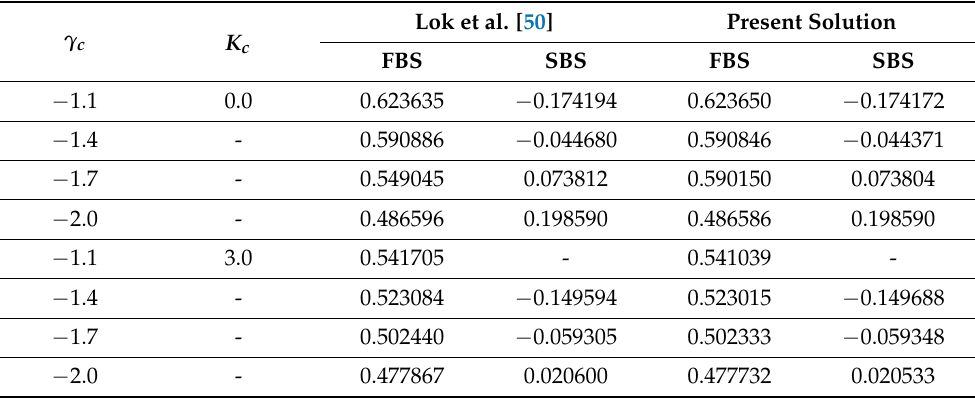
Table 3. Values of couple-stress coefficient for the several values of γ c and K c when ε c = 0, f w = 0,